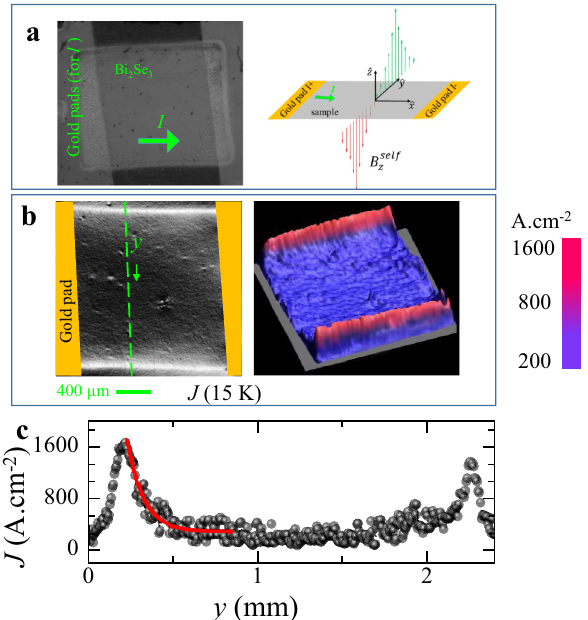
Figure 2. Edge current of thin film. ( a ) Figure shows an optical image of Bi 2 Se 3 film showing the Cr/Au electrical pads sputtered on the film surface. Adjoining image is a schematic representation of the behaviour of the z -component of the self-field distribution. ( b ) Shows as gray-scale images and 3D map of the J ( x, y ) distribution across the sample surface at 15 K. ( c ) The figure shows the J ( y ) profiles (measured along the dashed green line in b ) at 15 K. The red solid line is a fit to the data using J = J 0 exp ( − y